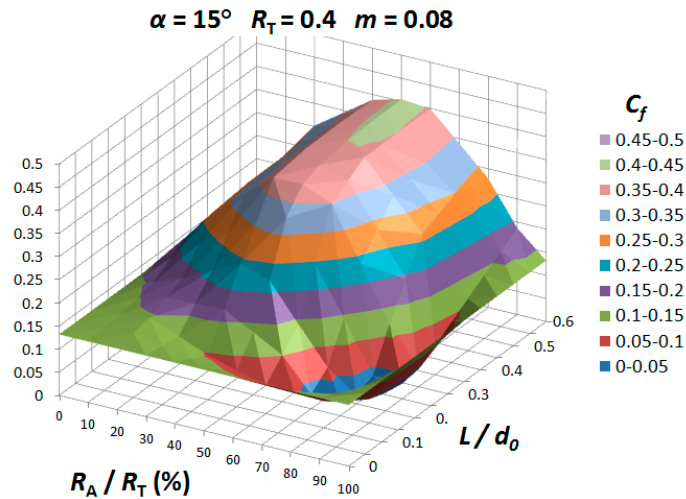
Figure 12. Surface of damage ( C f ) as a function of L and R A . Metals 2017 , 7 , 335